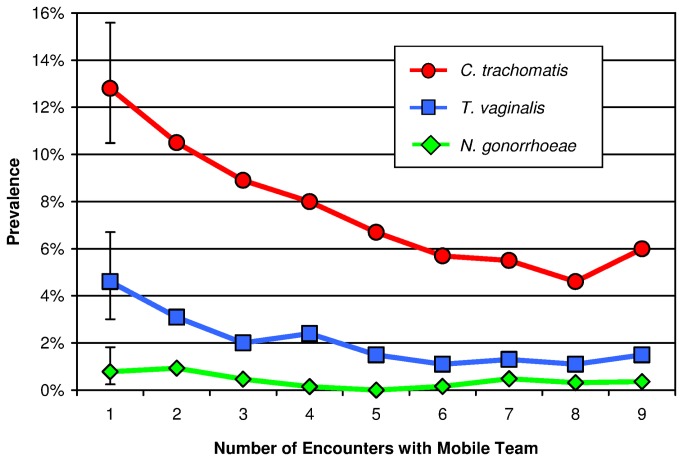
Prevalences of C. trachomatis, N. gonorrhoeae, and T. vaginalis among sex workers.The prevalences are presented in relation to the number of encounters with the Mobile Team. Analysis is restricted to 714 sex workers with at least nine encounters with the Mobile Team. 95% confidence intervals are shown for the first encounter. Reductions in prevalences are significant for C. trachomatis (p <0·001) and T. vaginalis (p <0·001), but not for N. gonorrhoeae (p =0·07). N. gonorrhoeae infection was defined by AMPLICOR NG OD ≥3·5, confirmed by positive Aptima Combo2 assay.